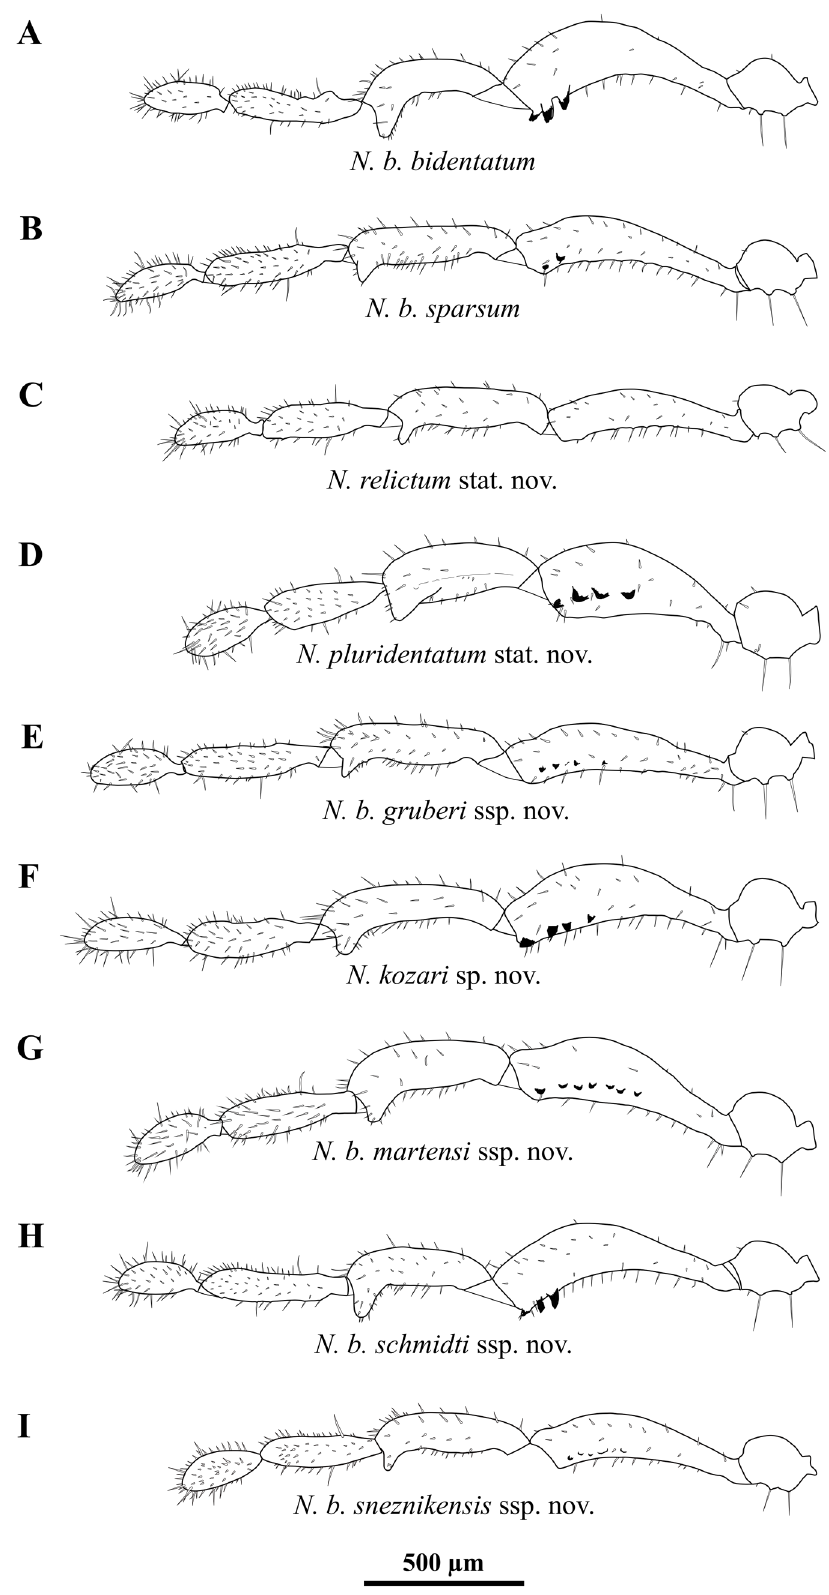
Fig. 5. Nemastoma bidentatum Roewer, 1914 complex, ♂♂. Pa (medial